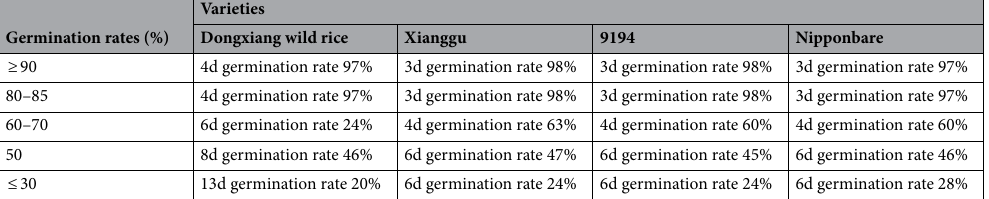
Germination rates (%)